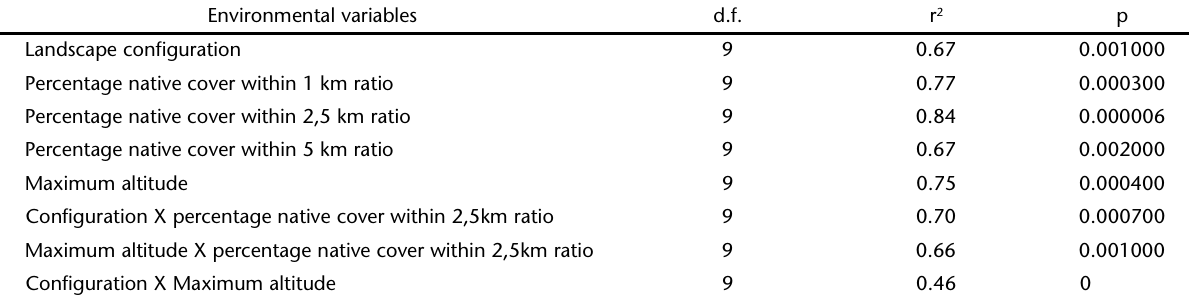
Table IV. Results of the Correlation Analysis between landscape configuration, native cover and maximum altitude (environmental variables) and the composition of mixed-species flocks (represented by the scores of the species with axis 1 of the Correspondence Analysis) of the remnants of the Atlantic Forest of the hydrographic basin of the Itajaí River, Santa Catarina, between April and August, 2007.